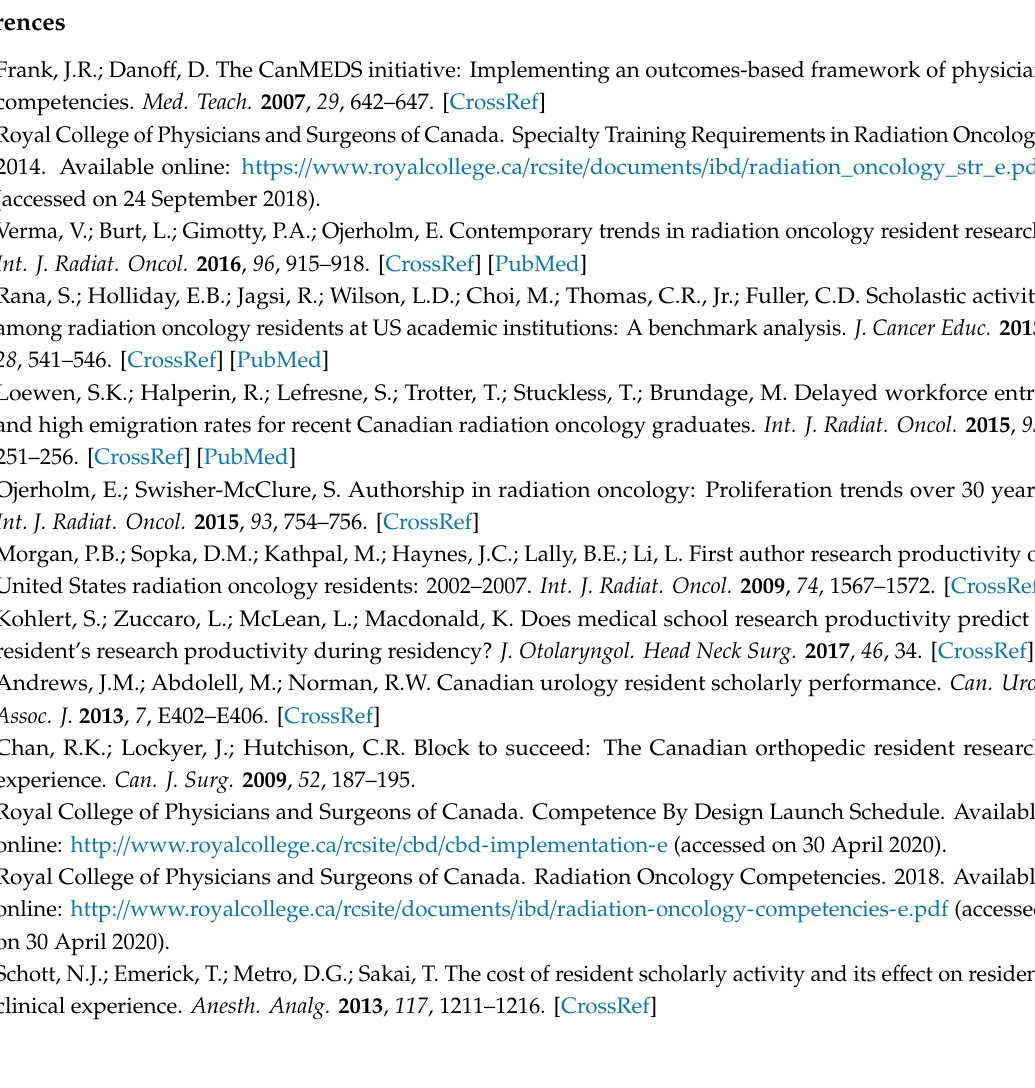
Table S1. Baseline characteristics of publishing residents stratified by first author publication reported per resident ( n = 227). Table S2. Baseline characteristics of publishing residents stratified by any author publication reported per resident ( n =